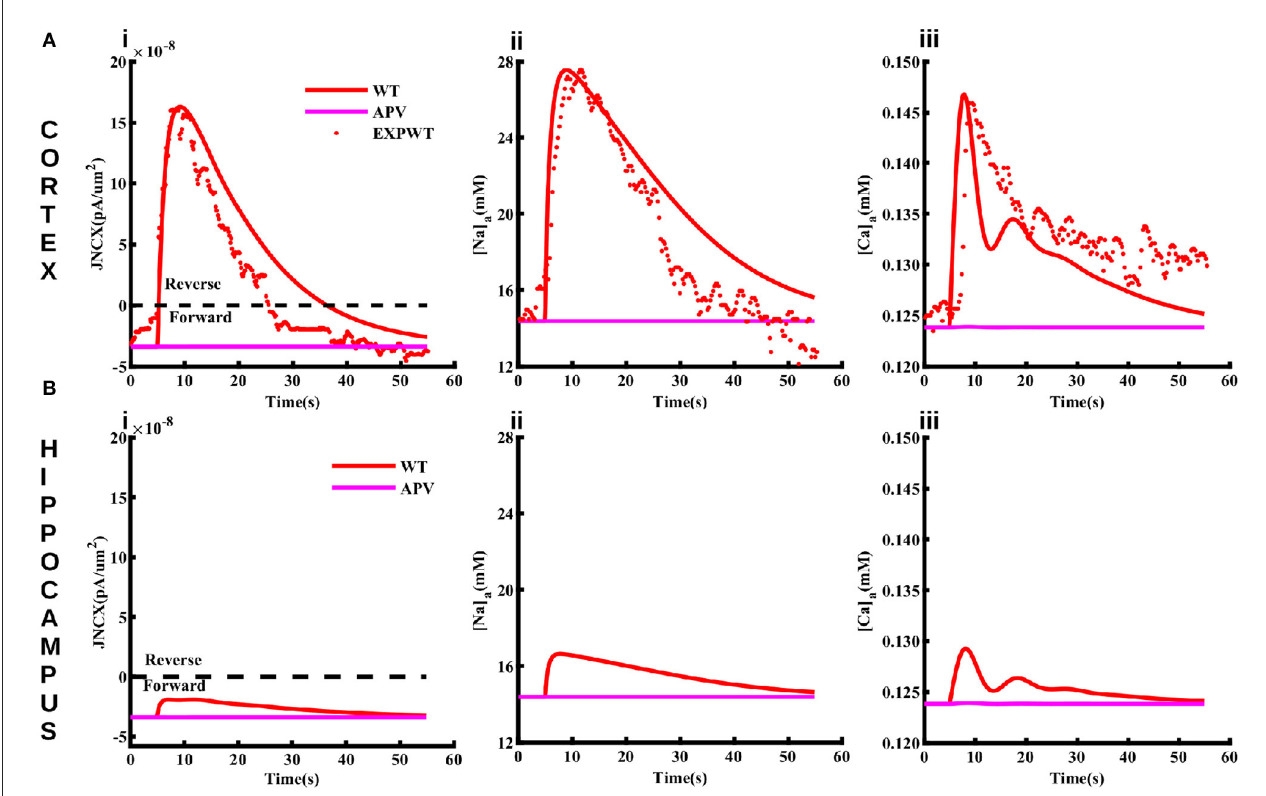
FIGURE5 The function of NCX differs in cortical and hippocampal astrocytes. Flux through NCX (Ai) , Na a (Aii) , and Ca a (Aiii) in cortical astrocyte in response to 4 mM NMDA (model-equivalent of 50 mM in the iontophoresis pipette) applied for 0.5 ms. The solid and markers represent simulated and experimental values, respectively. The values above (positive) and below (negative) the black line in (Ai) represent the reverse and forward modes of NCX. Blocking NMDA receptors using APV causes NCX to operate in the forward mode and suppresses the rise in Na a and Ca a (pink lines) in cortical astrocytes. (B) same as in (A) but for hippocampal